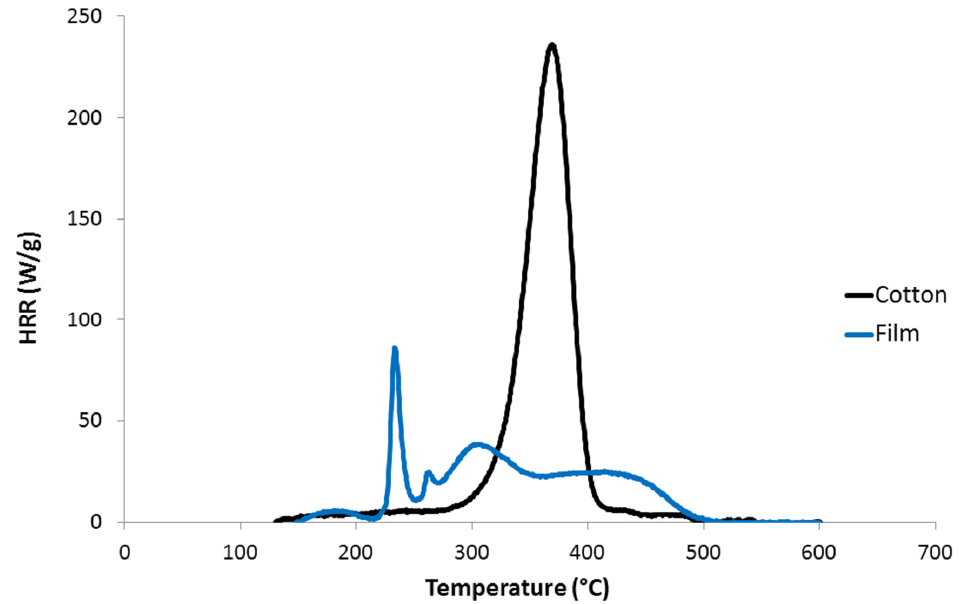
Figure 13. HRR versus temperature curves for cotton fibers and regenerated film prepared from a solution of [DIMIM][(MeO)(H)PO 2 ] containing 2 wt% of cotton